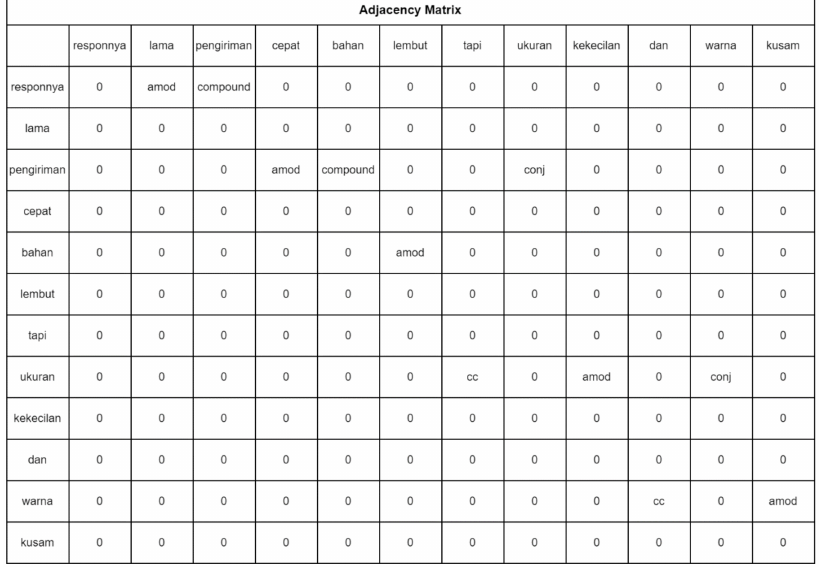
Figure 3. An example adjacency matrix of the dependency parse.